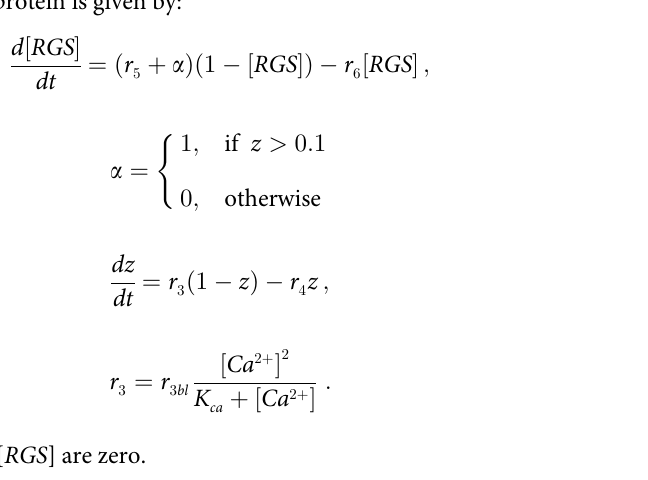
S1 Table. Values for all parameters and coefficients of the model.